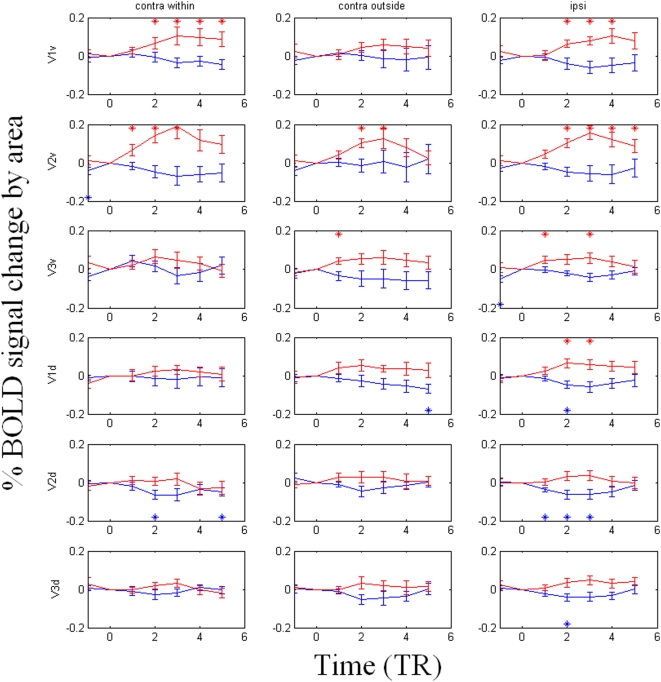
The differences of BOLD timecourses (TR = 1.6 seconds) upon perceptual switches in V1v, V1d, V2v, V2d, V3v, and V3d.The BOLD signal change averaged across voxels within subjects' ROIs and across hemispheres relative to the 16 slice volume acquisition (TR) = 0 position, corresponding to the beginning of a volume in which the subject reported a perceptual switch. The area is marked ‘contra within’ when the target was located inside the corresponding visual field, and marked ‘contra outside’ when target was located on the contralateral side to the ROI but outside the corresponding visual field. The area is marked ‘ipsi’ when the ROI was on the same side as the target that underwent MIB. The x-axis shows the time in units of TR (1.6 seconds), and the y-axis shows the percentage change of BOLD signal (%). The results show that the BOLD signal increased when the stimulus reappeared from MIB in V1v and V2v. The same result was observed when the stimulus was presented ipsilaterally to these areas. Statistics for Figures 5 and 6: N = 14; A two-tailed t-test was carried out to compare the value of TR = 0 (set to be zero) to the means of each TR individually. Those data points that are significantly different than 0 are marked as ‘*’ (p<0.05).